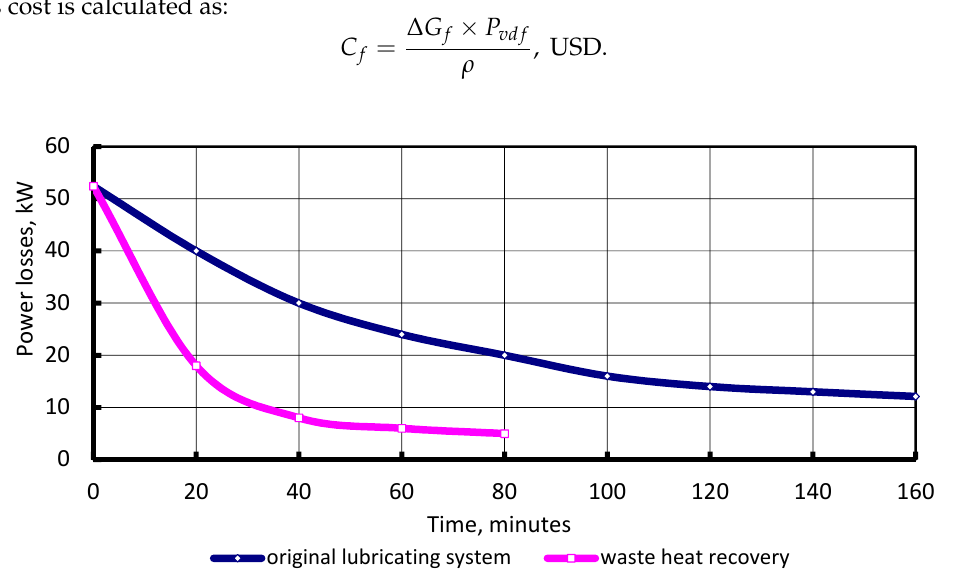
Figure 12. Power losses in the hydraulic clutch gearbox of T-150K. Source: adapted from [36].